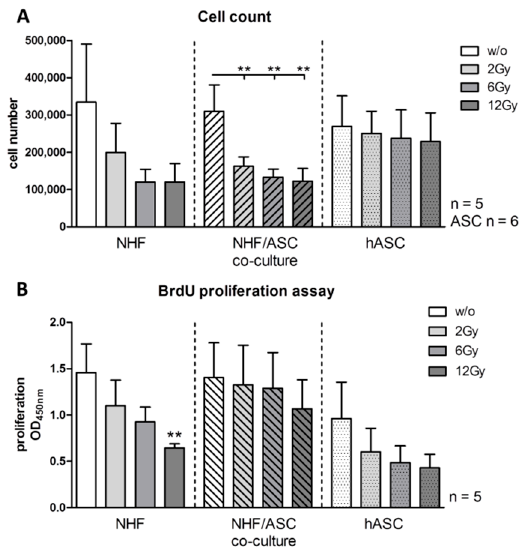
Figure 1. Absolute cell numbers ( A ) and cell proliferation ( B ) of viable adipose-derived stem cells (ASC), normal human fibroblasts (NHF) and the co-culture of ASC and NHF 48 h after irradiation with 2 to 12 Gy compared to unirradiated control cells determined by BrdU incorporation assay. Error bars represent standard error of the mean ( n = 5, cell numbers ASC n = 6). ** p < 0.01. 2.1.2. Gene Expression of MMP1 and MMP2 in Normal Human Fibroblasts (NHF), Adipose-Derived Stem Cells (ASC) and Co-Culture of NHF and